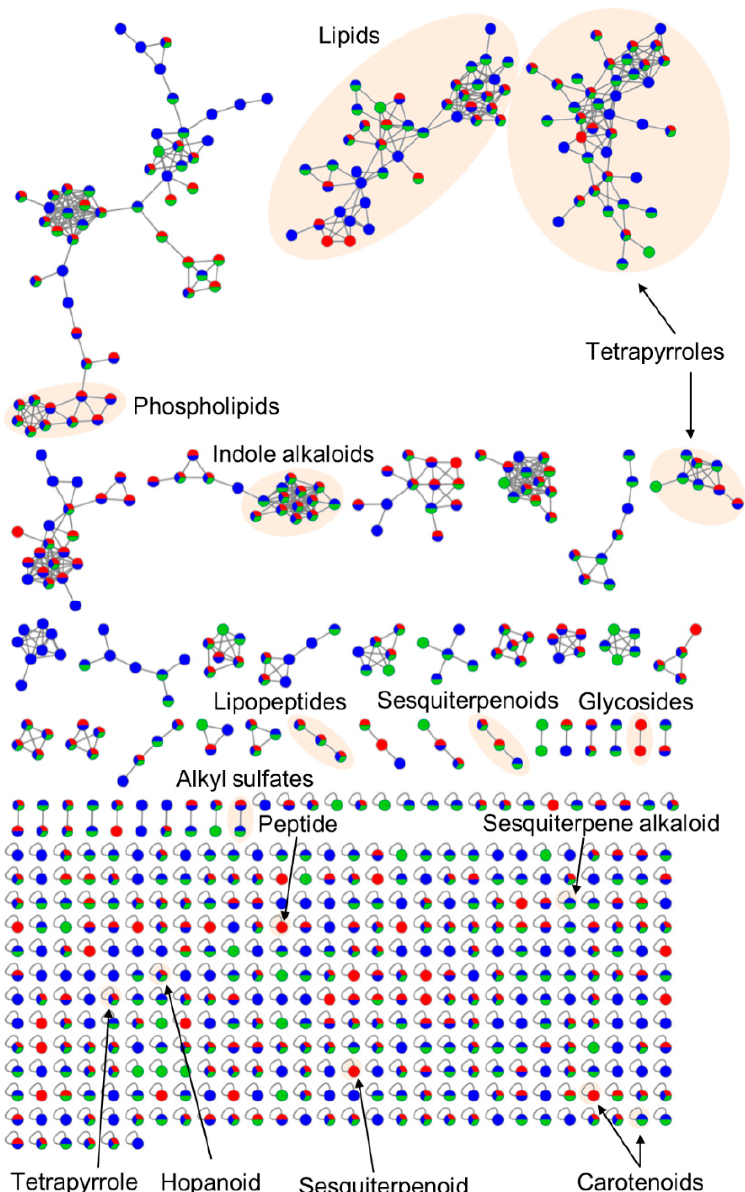
Figure 3. Global molecular network (MN) of three different C. intestinalis populations. The MN was constructed via the online platform GNPS [26] by using pre-filtered MS/MS-data of the population level metabolome study. Nodes are color-coded and reflect their sampling site: red: Canada, blue: Helgoland, green: Kiel. Putatively annotated clusters or nodes are highlighted.